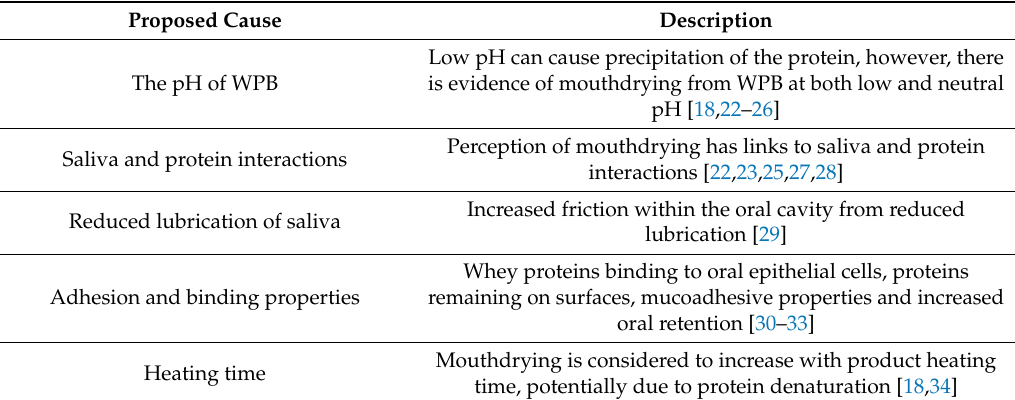
Table 1. Commonly proposed causes of whey protein beverage (WPB) derived